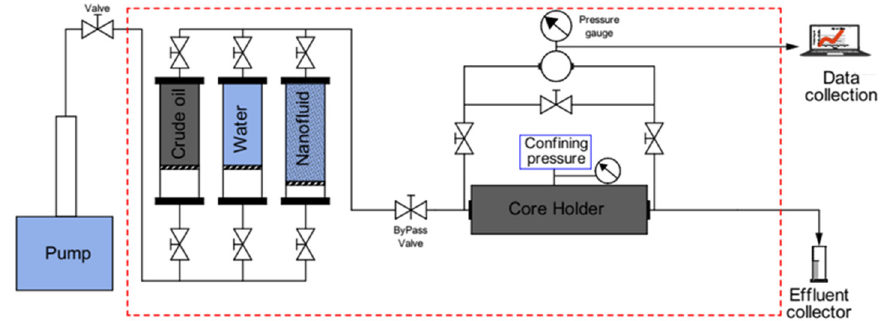
Figure 3. Schematic diagram of the core flooding system.